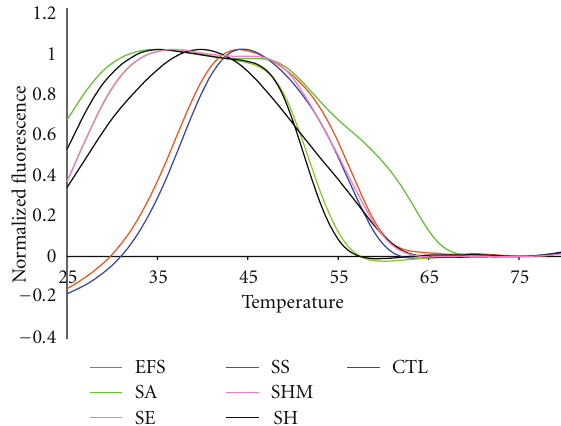
Figure 3: The normalized anneal curve showing all Gram positive 16S targets in the Quasar channel with their highest peak normal- ized to